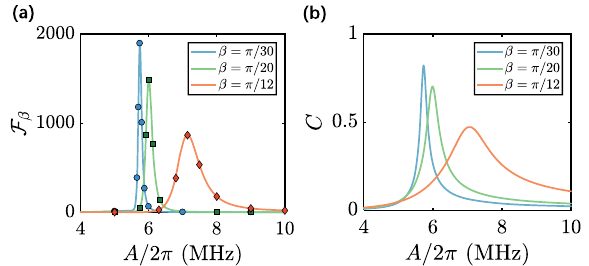
Fig. 4 Numerical simulation of the QFI and quantum entangle- ment in a strongly correlated two-qubit system. a The QFI F β of the ground state Ψ 1 j i . The data points obtained from the simulation of the experiments agree well with the exact theoretical values (solid lines). b The concurrence C of ground state Ψ 1 j i . The parameters we use are A ⊥ = (2 π )2.79 MHz, A ∥ = (2 π )11.832 MHz and B z = 504 G. The values of the modulation strength, a k , are chosen such that the Rabi frequency of the induced coherent oscillation is much smaller than the corresponding energy gaps, see Ref. 22